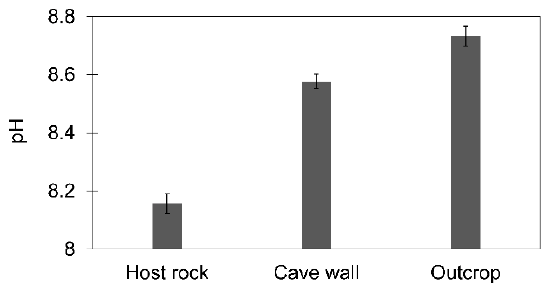
Figure 4. pH values of host rock and stalactite minerals from the cave wall and outcrop.